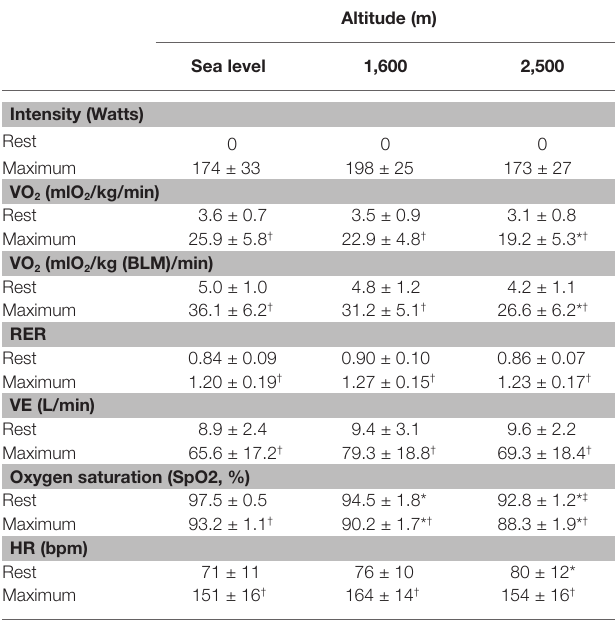
TABLE 5 | Resume of cardiorespiratory variables evaluated at maximum exercise that work at several altitudes. Altitude (m) Sea level 1,600